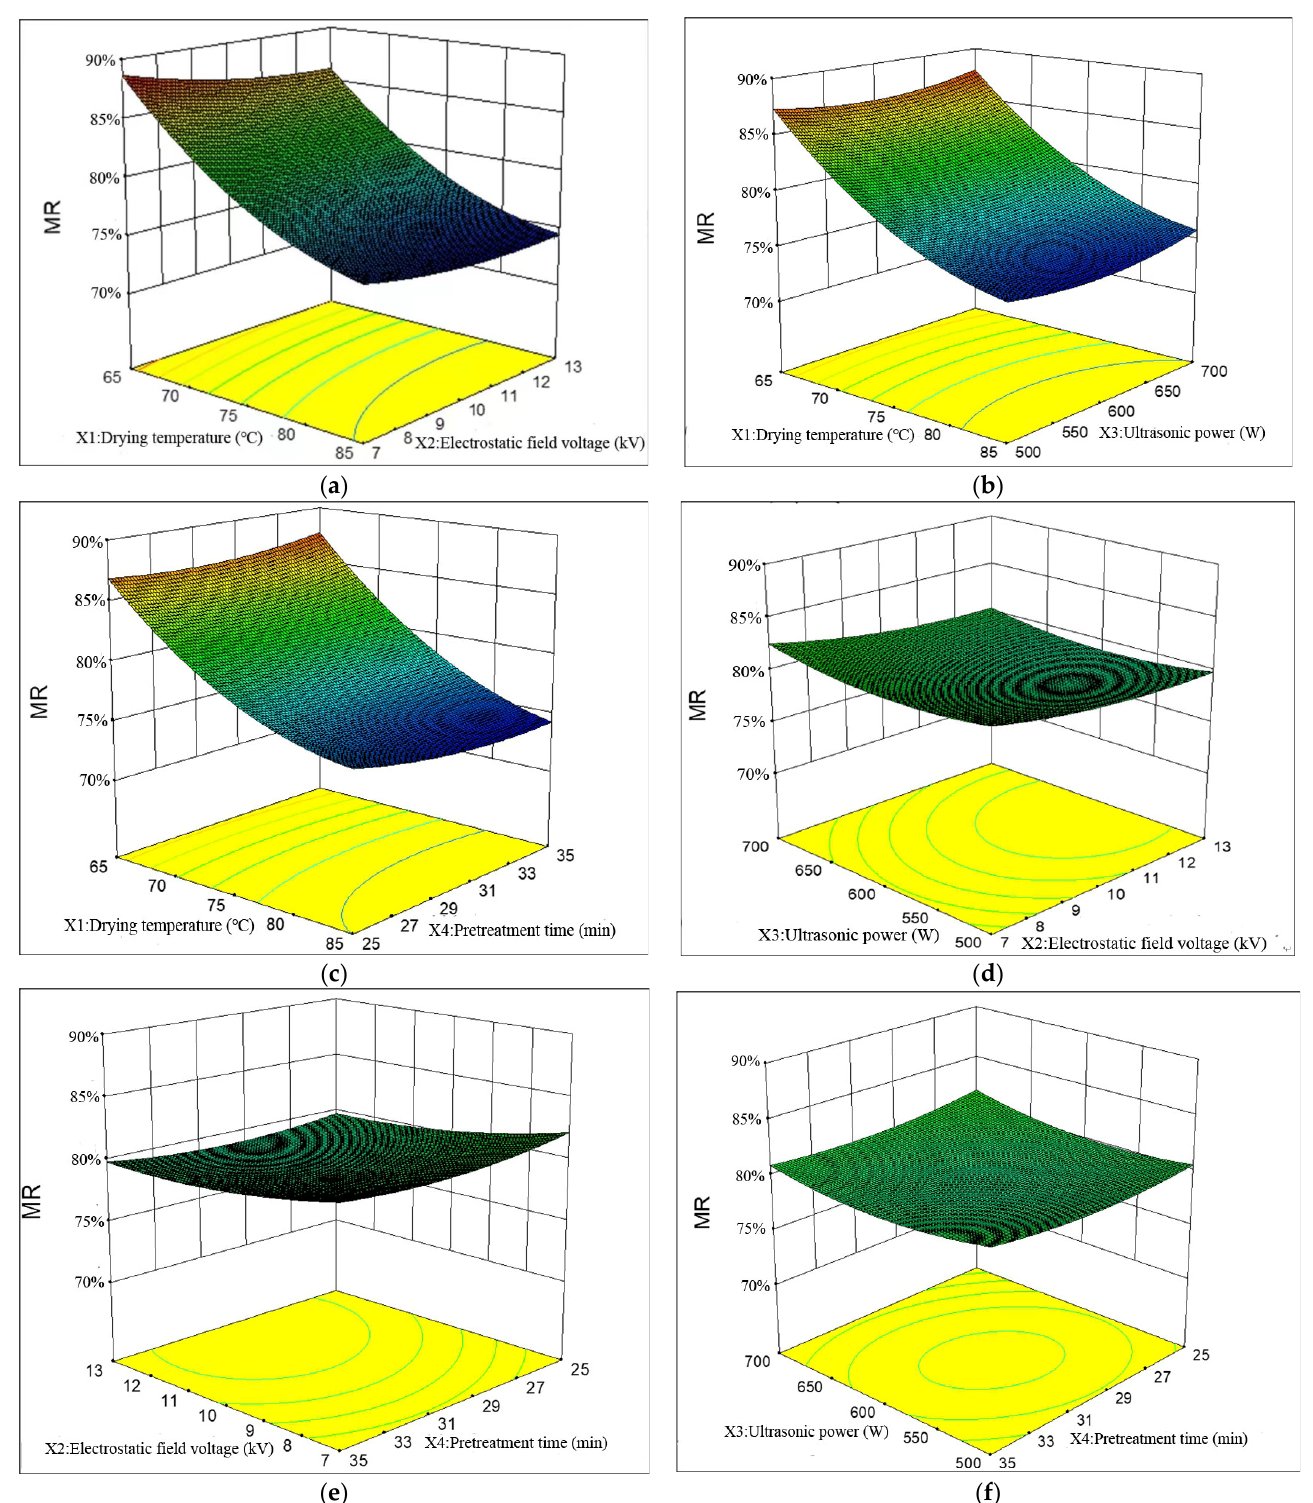
Figure 6. Three-dimensional response surface diagram of effects of dryingfactors on moisture content of ginkgo fruits: ( a ) hot air drying temperature and electric field voltage, ( b ) hot air drying temperature and ultrasonic power, ( c ) hot air drying temperature and pretreatment time, ( d ) electric field voltage and ultrasonic power, ( e ) electric field voltage and pretreatment time, ( f ) ultrasonic power and pretreatment time.